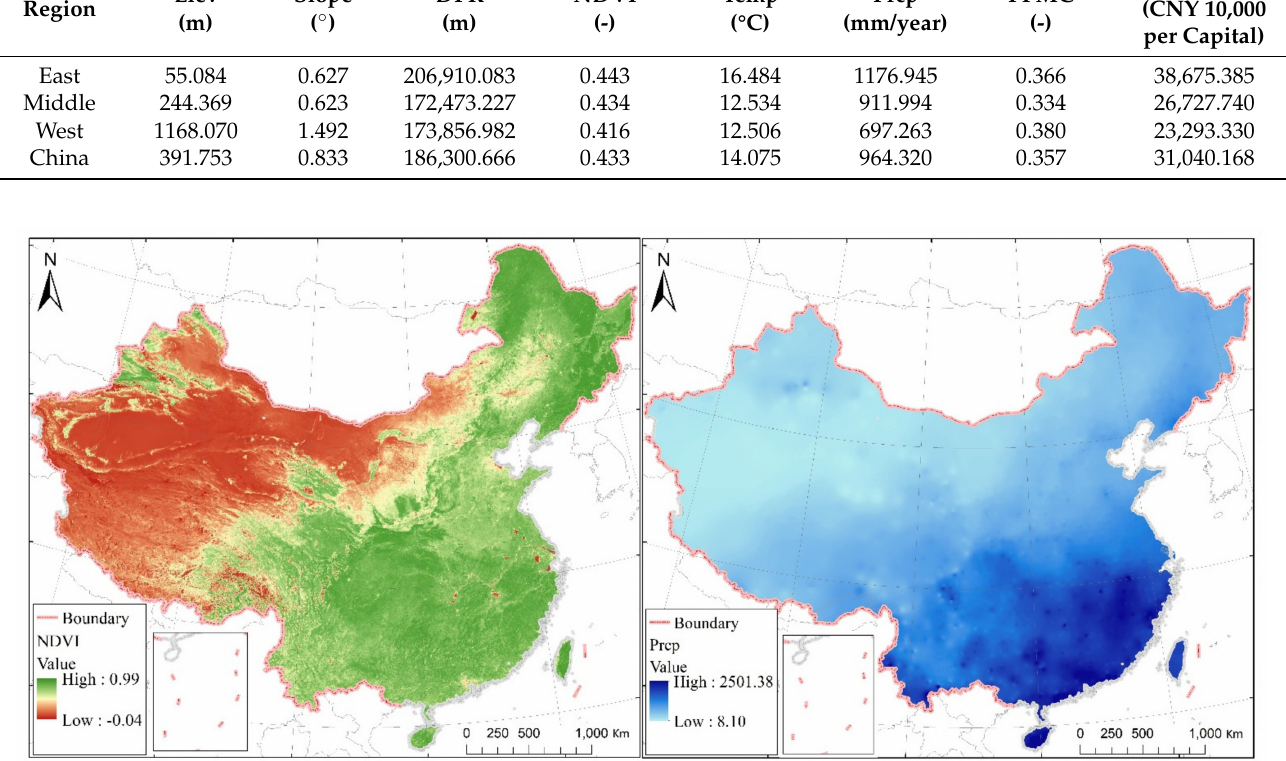
Figure 3. Annual average NDVI and Prcp maps of